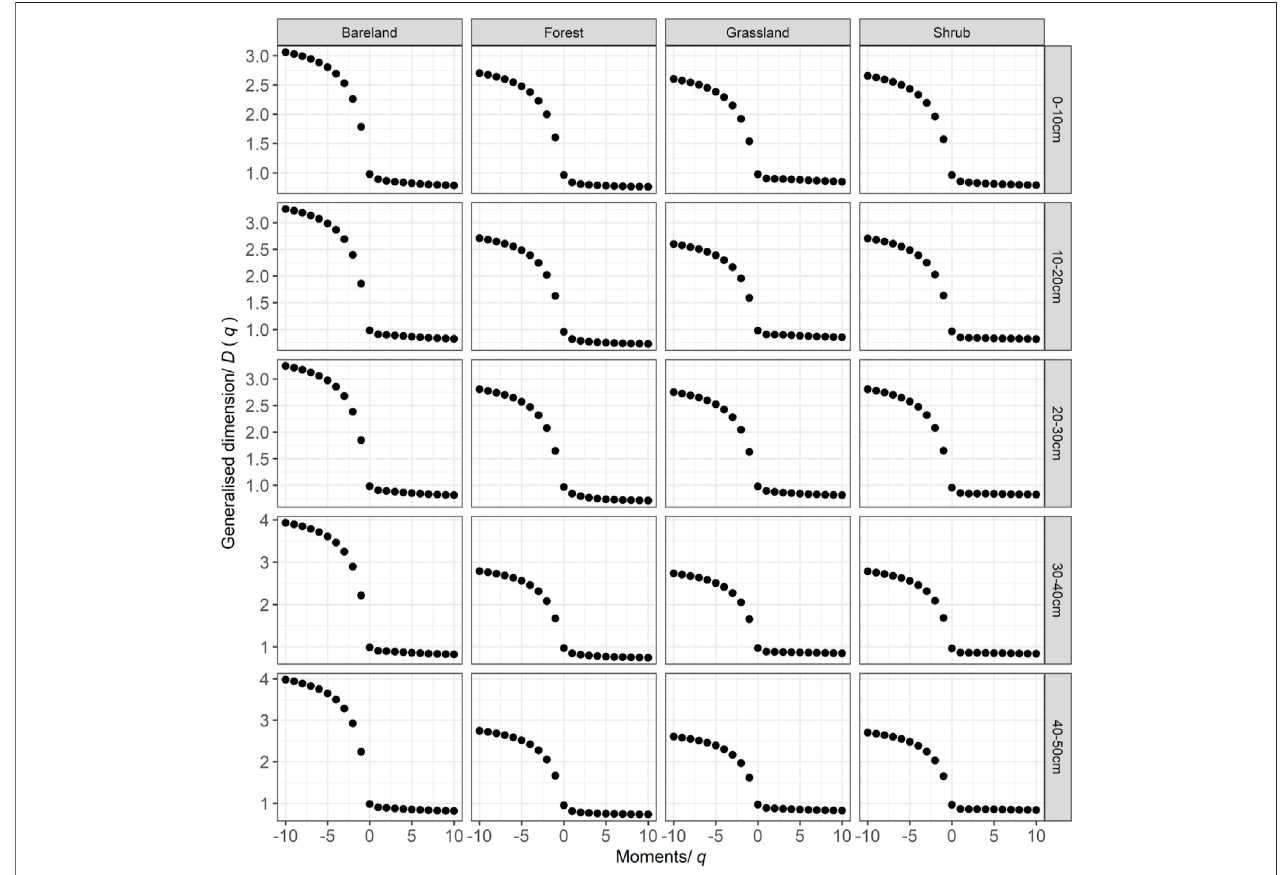
FIGURE 4 | Generalized dimension spectra D ( q )- q of soil particle-size distribution in different soil layers of four vegetation types in Jiangjiagou Gully.